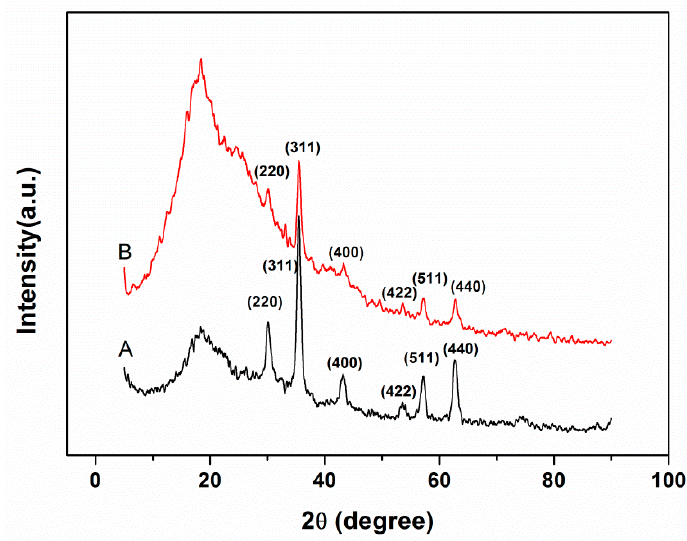
Figure 3. XRD patterns of magnetic PGMA ( A ) and magnetic PGMA-g-PPy ( B ).